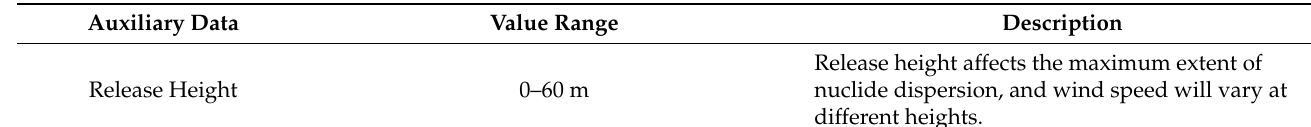
Table 2. Release height and meteorological parameter setting